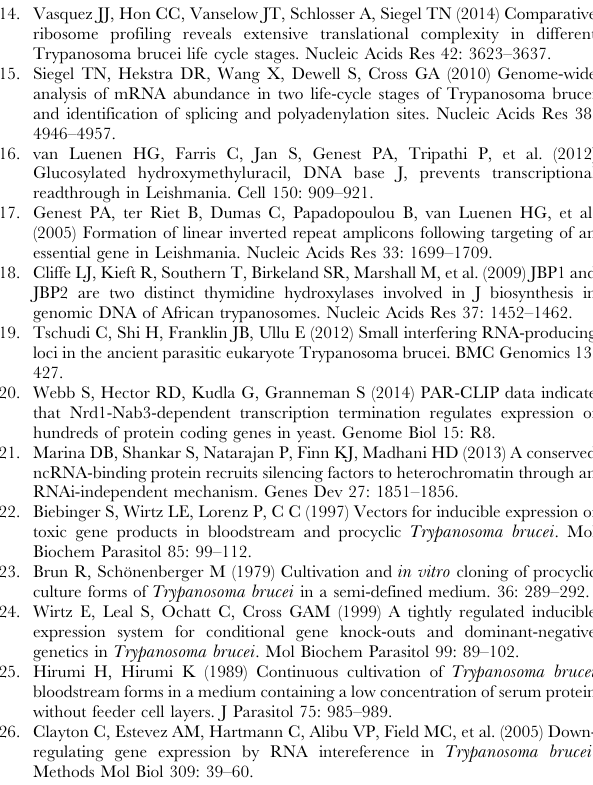
Figure S5 RNaseH treatment. To assess whether the transcripts detected with probe B in Figure 5 are polyadenyated, RNA samples obtained from RBP33-depleted cells were incubated with RNase H in the absence ( 2 ) or presence ( + ) of oligo(dT). Table S1 List of transcripts associated with RBP33. Transcripts with a log 2 FC enrichment . 3 (Sheet 1) or . 2 (Sheet 2) with respect to the input sample are shown. Table S2 Oligonucleotides used in this work. List of the oligonucleotides designed for Northern and quantitative RT-PCR assays.